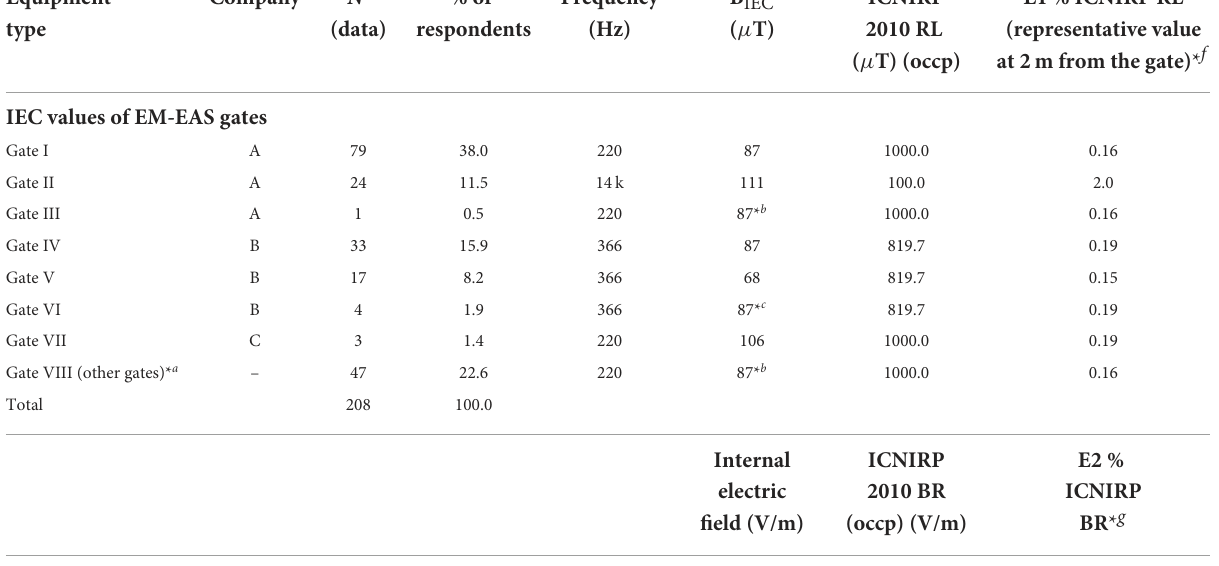
TABLE 2 Types, specifications, and the results of the measurement (E1) and calculation (E2 and E3) of exposure levels from EAS gates and BCUs.